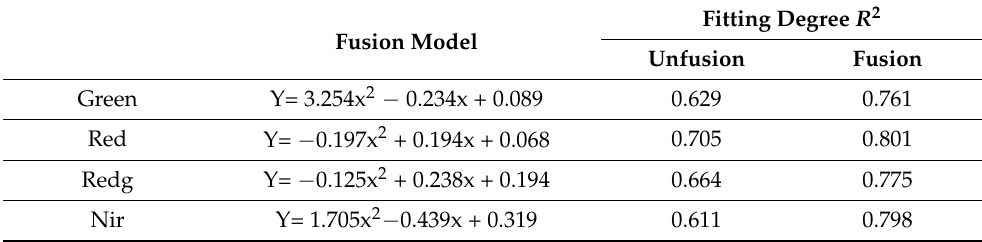
Table 2. UAV-ground band fusion model and fitting